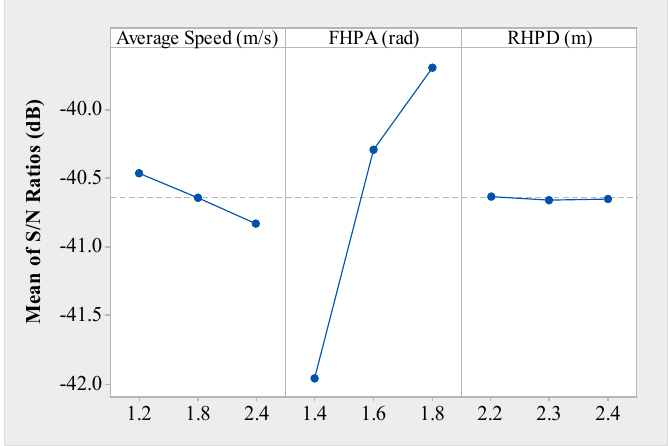
Figure 4. Mean S/N ratio trend for A(8). (FHPA: front harrow pin angle; RHPD: rear harrow pin distance; S/N: signal to noise ratio).